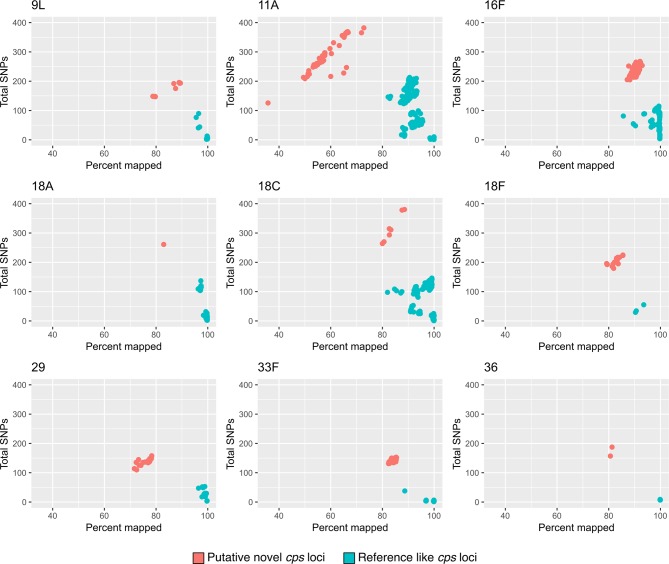
Identification of putative novel cps loci; plots of total SNPs against the percentage of the serotype reference covered by sequence reads are shown for nine serotypes with putative novel cps loci (highlighted in red).